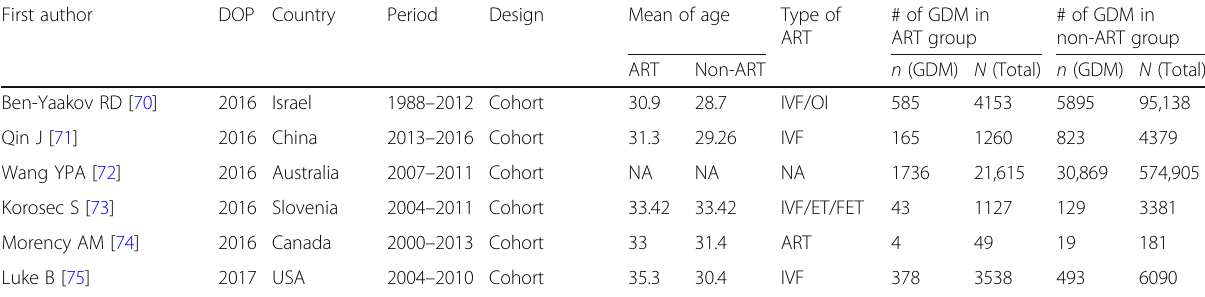
Table 2 Characteristics of the primary studies included in the meta-analysis (Continued)